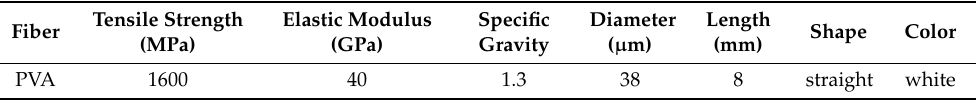
Table 1. Mechanical and physical properties of PVA fiber.